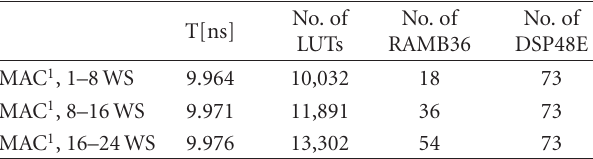
Table 4: Post-place & route